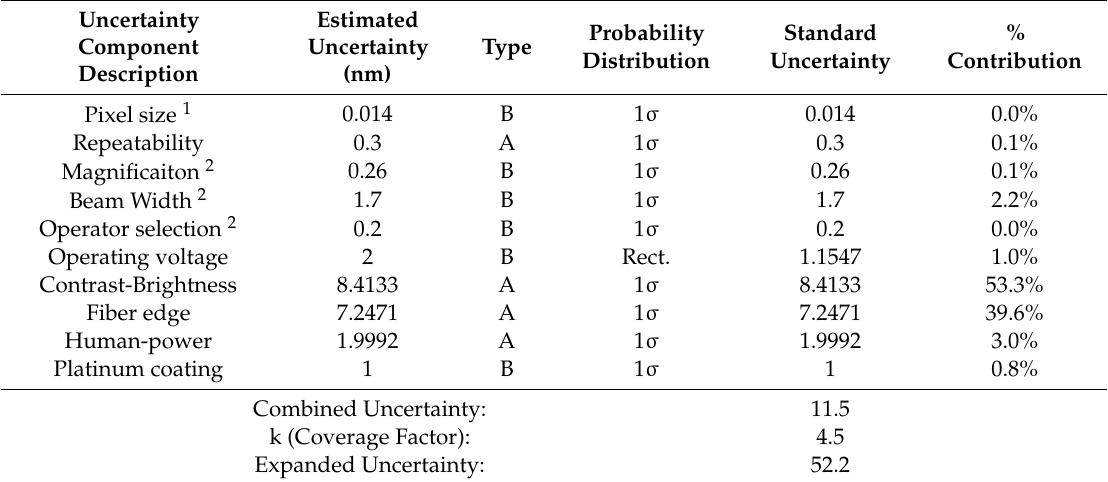
Table A3. Uncertainty budget for measured values presented in relation to Figure